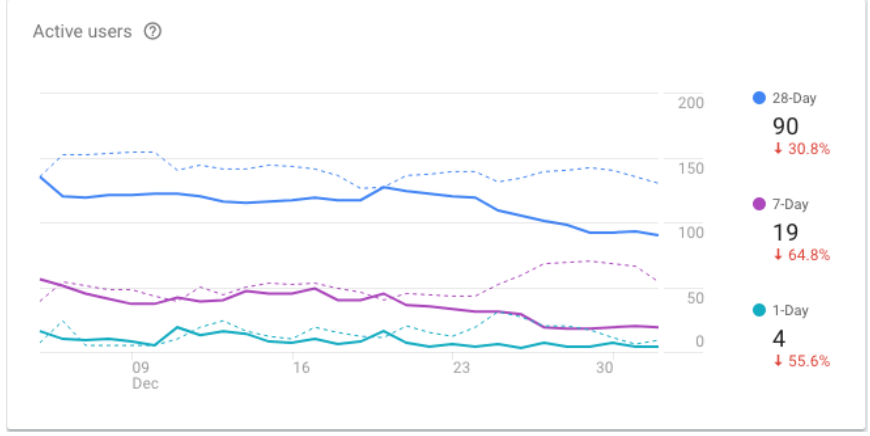
Figure 16. TeenPower mobile app — active users (30-day period starting on December 4, 2018).